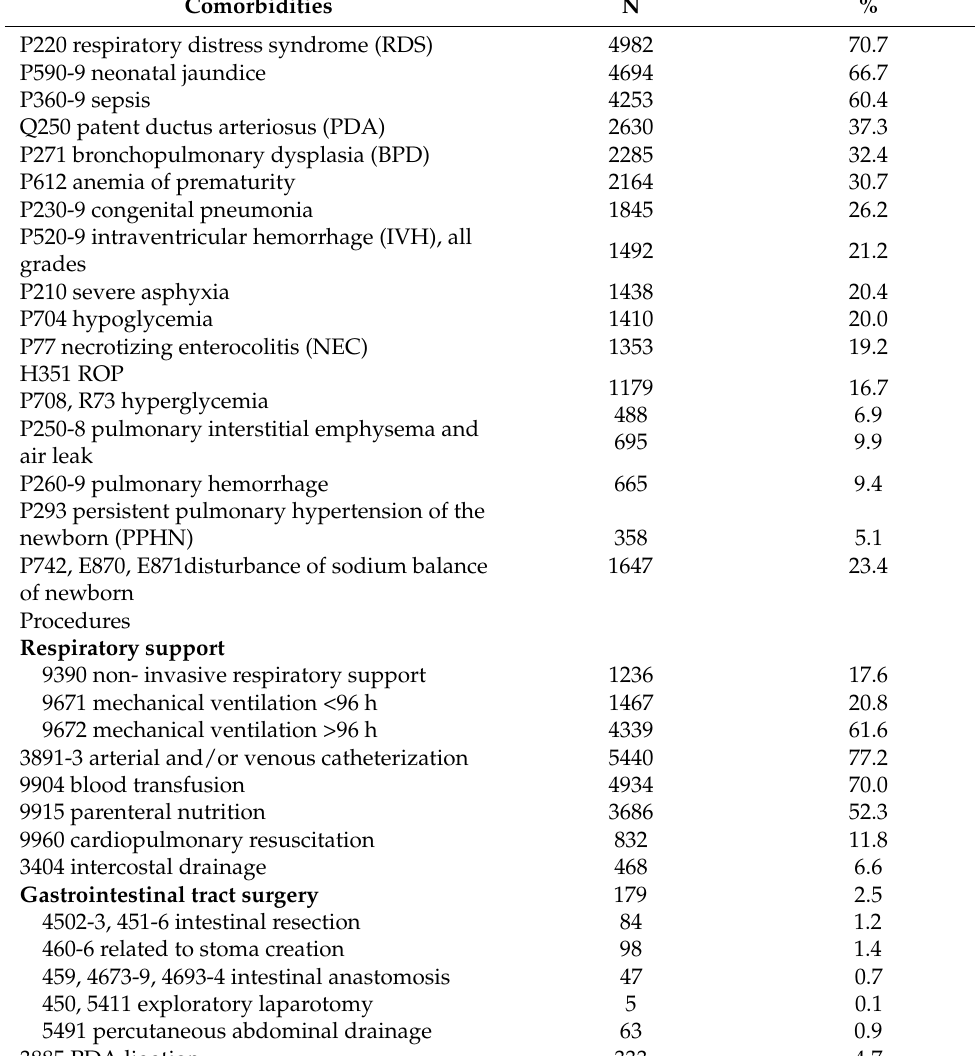
Table 2. Comorbidities and procedures performed in 7042 ELBW